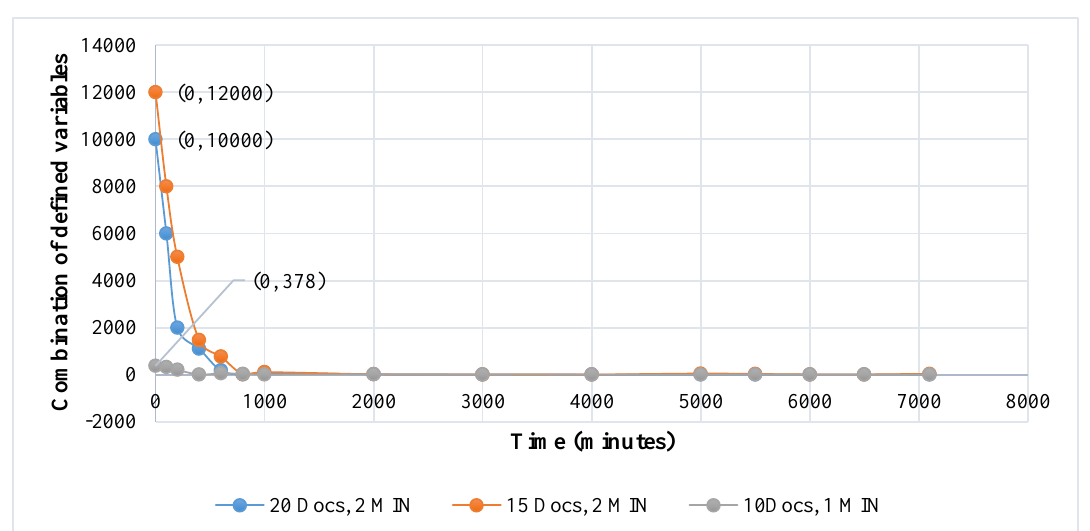
Figure 8. Computational Time (s) Plotted Against